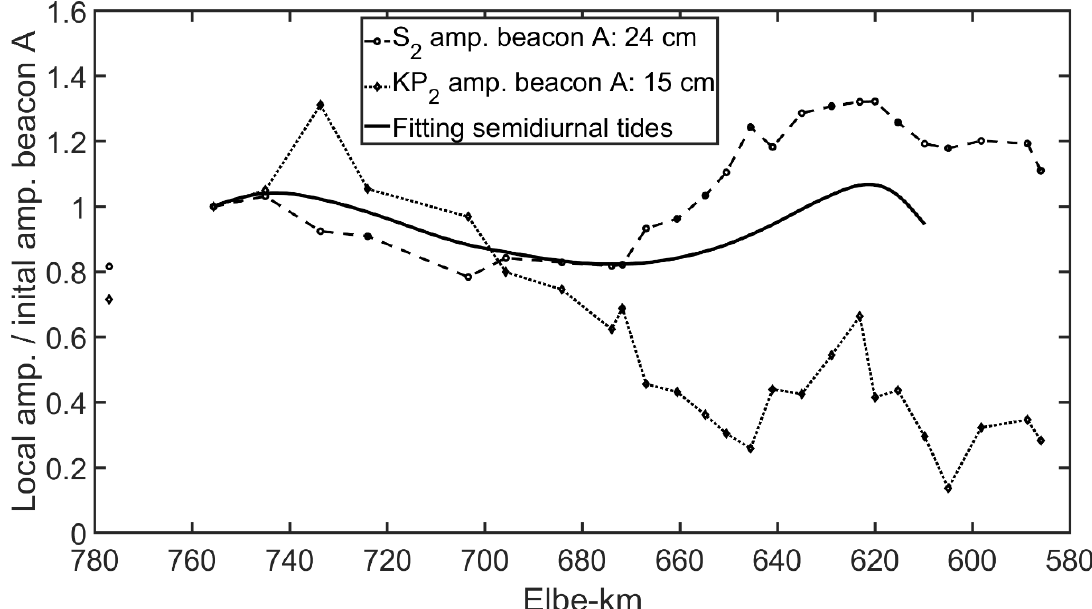
Figure 7. Tidal constituents S 2 and the shallow water compound tide KP 2 considering only its nodal amplitude correction f without the phase correction. The fitting curve includes amplitudes of M 2 , S 2 and N 2 without consideration of compound tides.